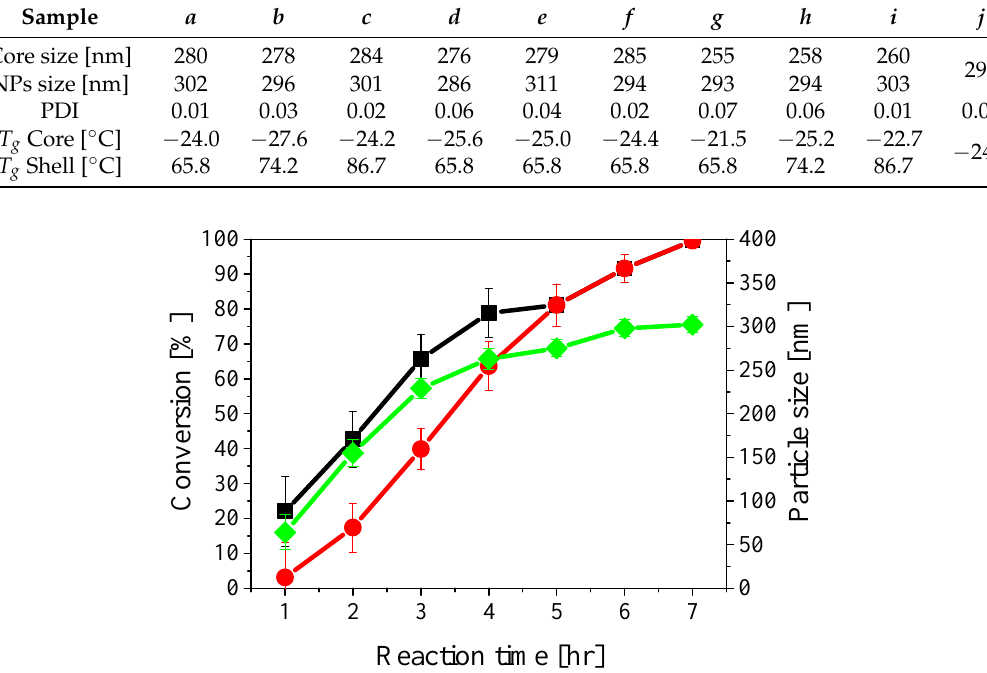
Figure 2. Instantaneous (black squares) and cumulative (red circles) conversion and average particle size (green diamonds) during the synthesis of sample a .